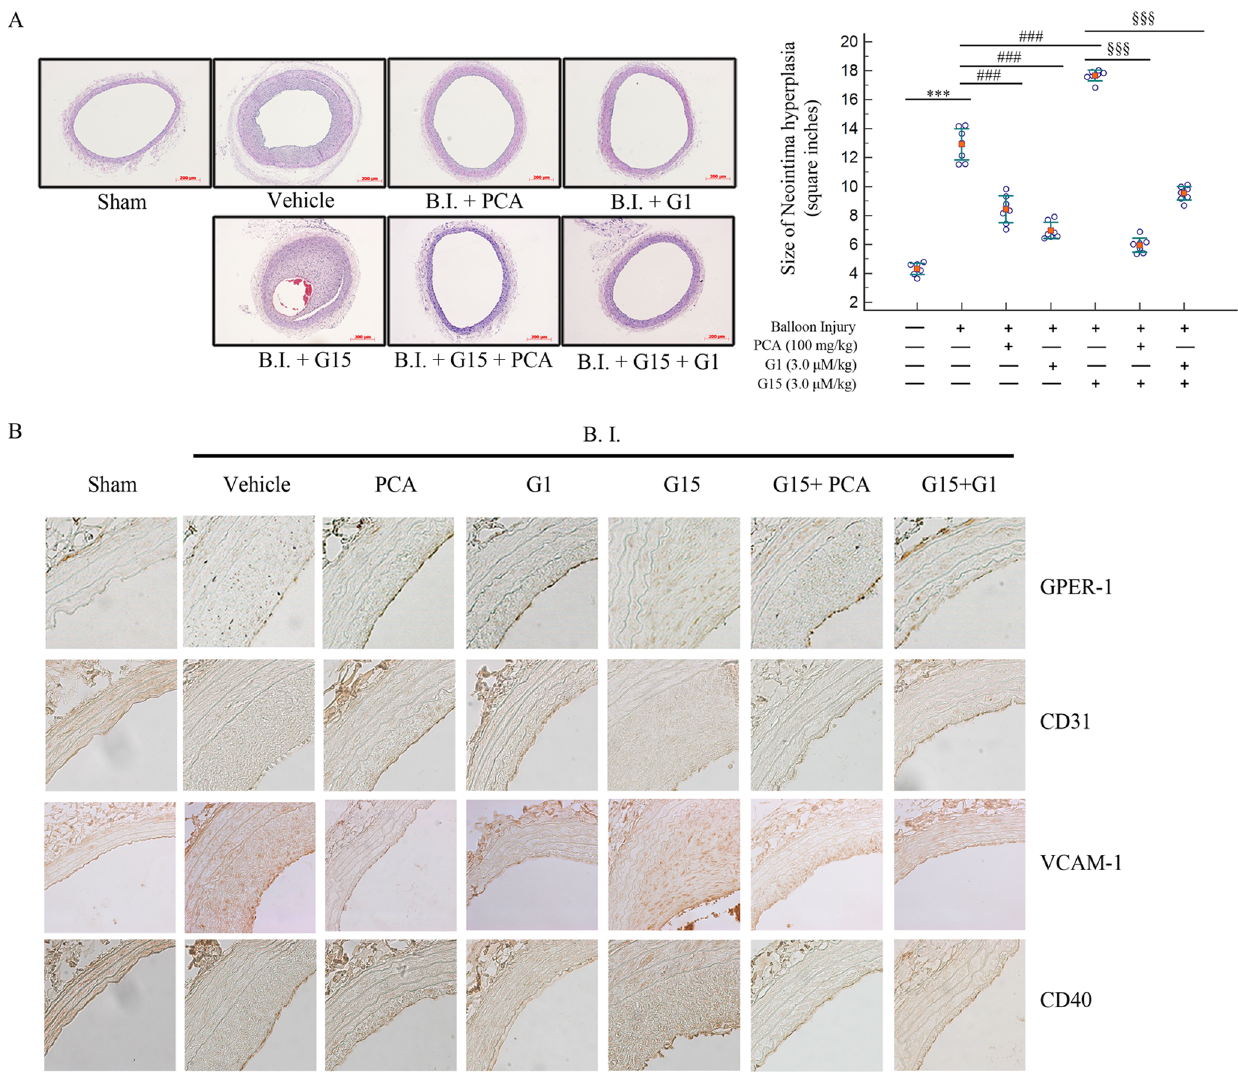
Figure 6. The effects of PCA, G1, G15, G15 + PCA, and G15 + G1 in CCA balloon-injured Sprague Dawley rats. ( A, B ) Seven-week-old Sprague Dawley rats (200 g) were treated with each substance by intraperitoneal injection for 2 weeks and then common carotid arteries from the rats were balloon injured. Substances were injected for another 4 weeks and then sacrificed for ( A ) H & E staining of common carotid arteries. Graph shows the percentage of neointima areas of Sprague Dawley rats from each group (n=7). Measurements were made using Scion Image software. ( B ) immunohistochemistry of rat aortas shows GPER-1 expression in the linings of the aorta from the same tissues used for Figure 5A. Data are presented as mean 6 SEM; *** indicates P , 0.001 compared to the sham group. ### indicates P , 0.001 compared to the vehicle group. 111 indicates P , 0.001 compared to the G15 + Inj. group.